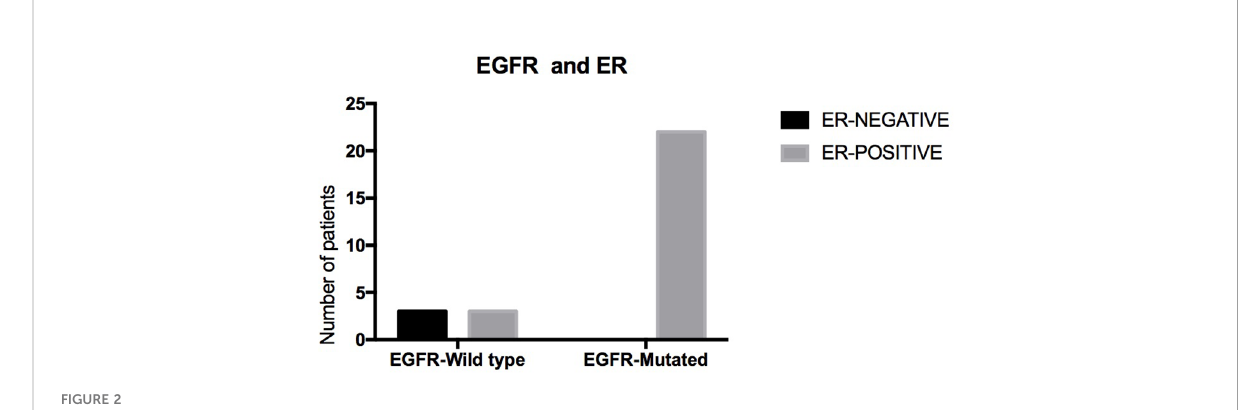
FIGURE 2 Relevance of status of EGFR and ER.